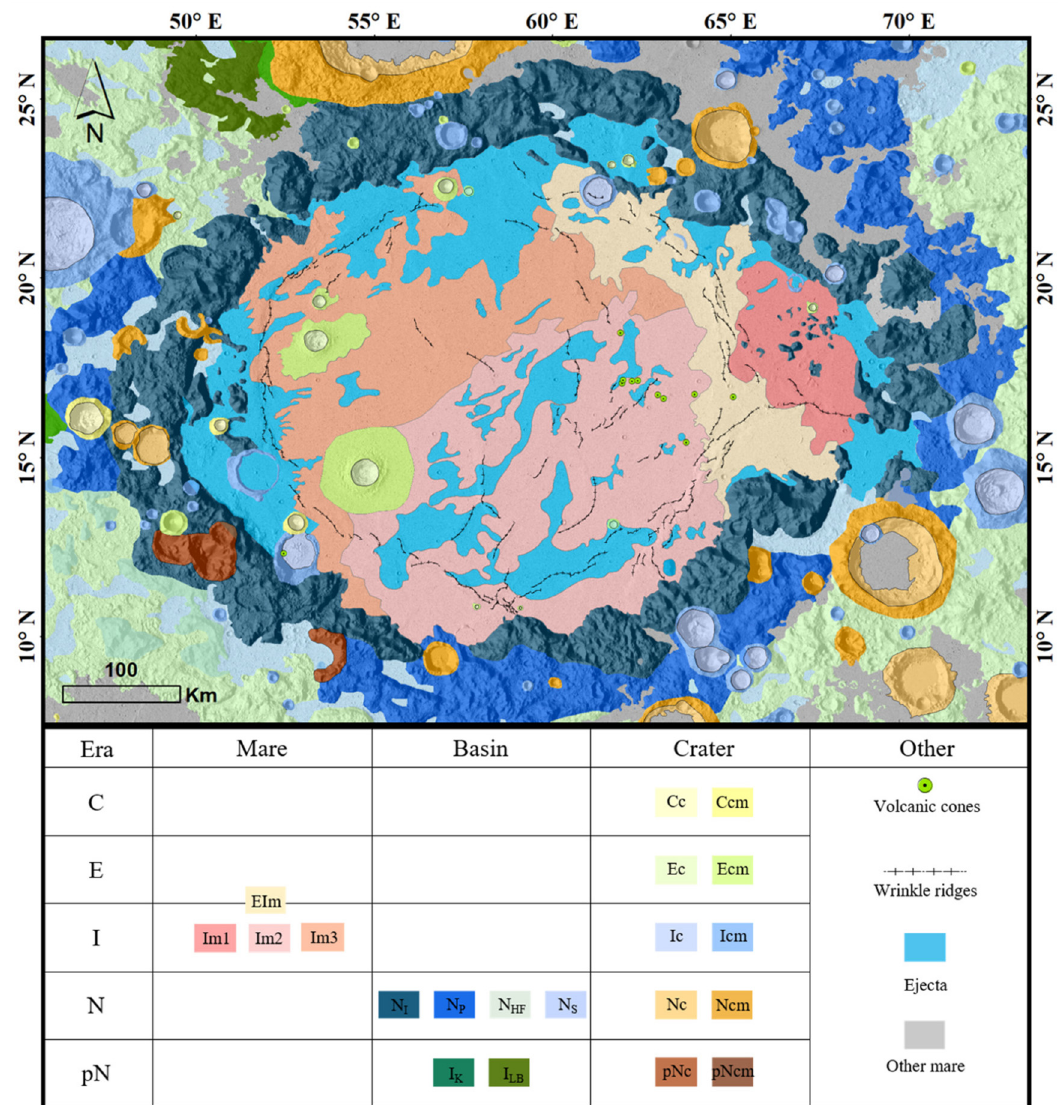
Figure 13. The geologic map of the Crisium